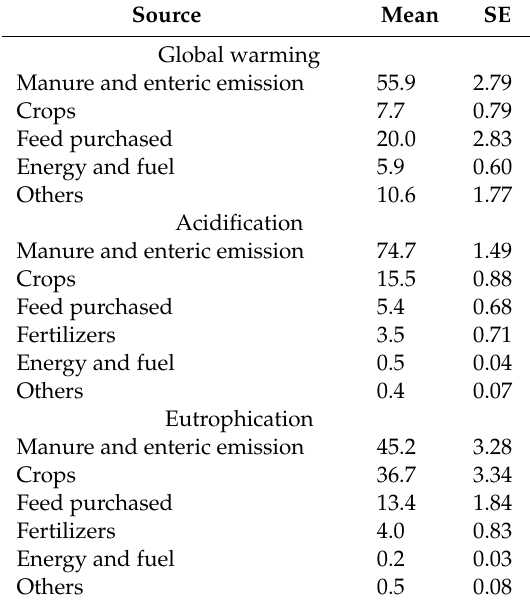
Table 2. Contribution (%) to global warming, acidification and eutrophication of di ff erent sources in BASE